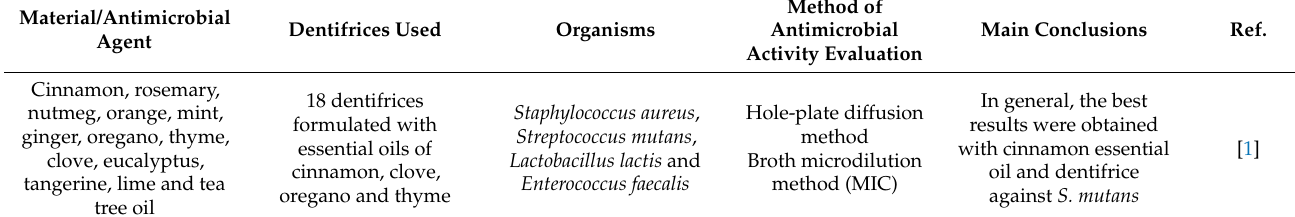
Table 1. Summary of included